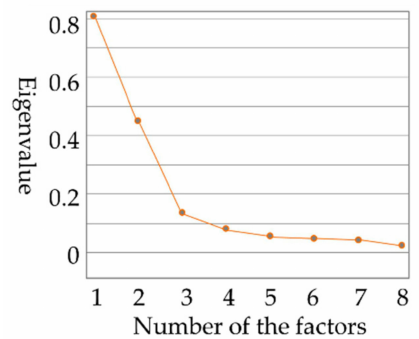
Figure 4. Scree plot of the information content of each factor.